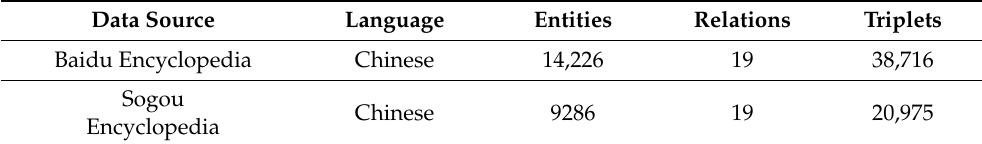
Table 1. Multimodal person entity alignment dataset statistics.